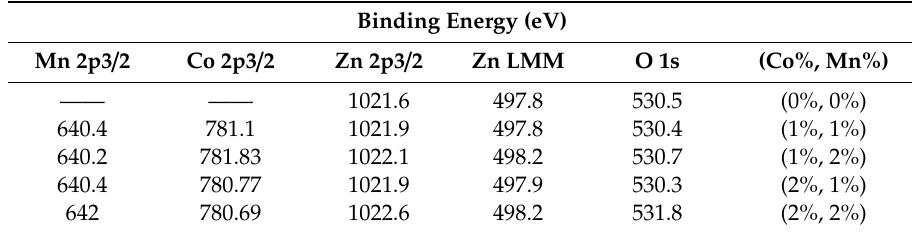
Table 4. XPS measurements of binding energy of O 1s, Zn LMM, Zn 2p3/2, Co 2p3/2, and Mn 2p3/2 of the undoped and (Co%, Mn%) co-doped ZnO.